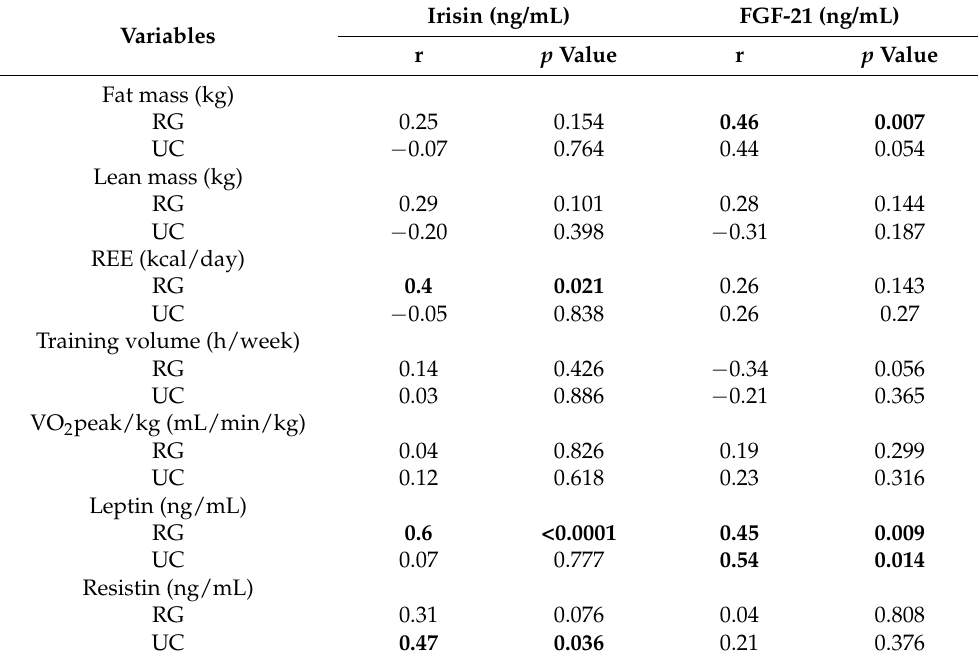
Table 3. Relationships of irisin and fibroplast growth factor-21 (FGF-21) with energy measures in rhythmic gymnasts (RG) and untrained controls